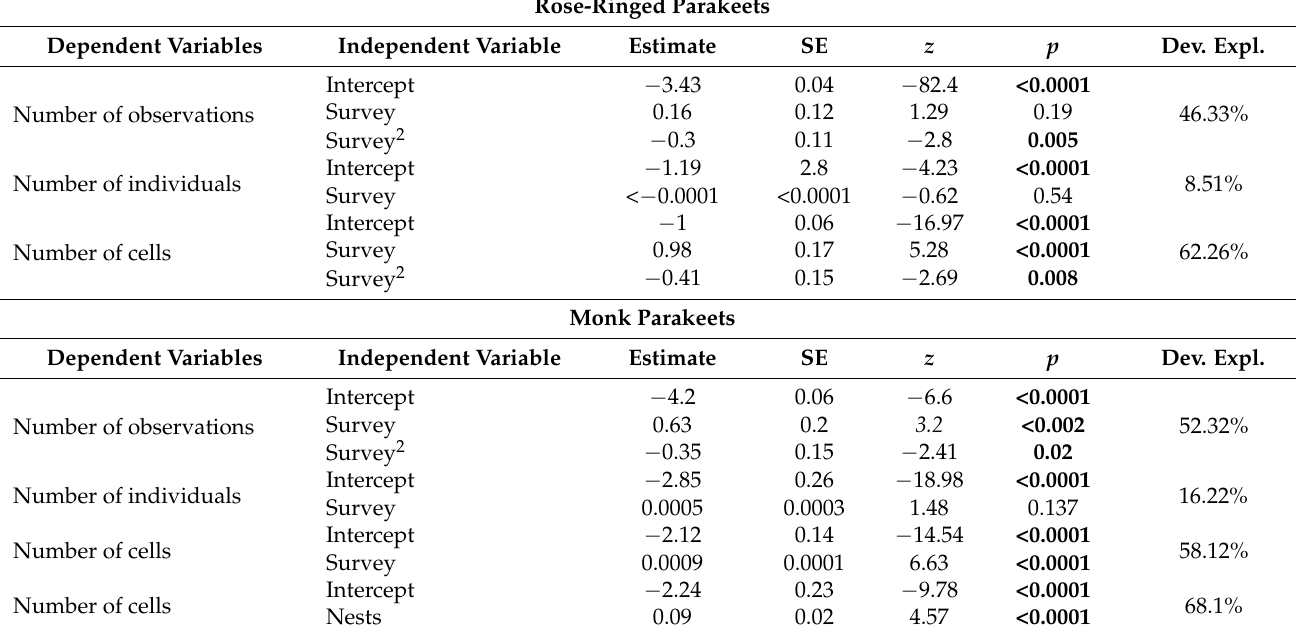
Table 1. Models obtained to relate the number of rose-ringed and monk parakeet observations and individuals recorded in the citizen science platforms to our annual population counts (Survey) conducted in the metropolitan area of Seville from 2013 to 2021. The number of bird observations recorded in these platforms was fitted as an offset to control for changes in sampling effort over years. We also include models obtained to relate the number of cells with rose-ringed and monk parakeet observations recorded in these platforms to the annual population counts and the number of cells with monk parakeet nests (Nests). The number of cells with bird observations recorded in these platforms was fitted as an offset to control for changes in sampling effort over years. Dev. Expl.: deviance explained. p -values in bold font indicate statistical significance ( ≤ 0.05). See Table S5 for outputs of all the models that were